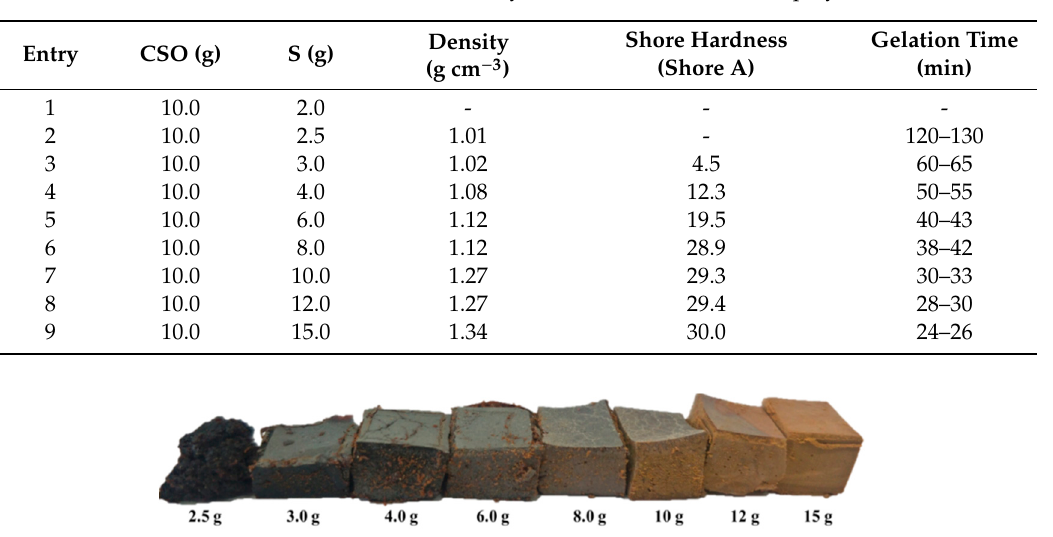
Table 1. Effect of sulfur content on density and hardness of bio-based polysulfides. Table 1. E ff ect of sulfur content on density and hardness of bio-based polysulfides.